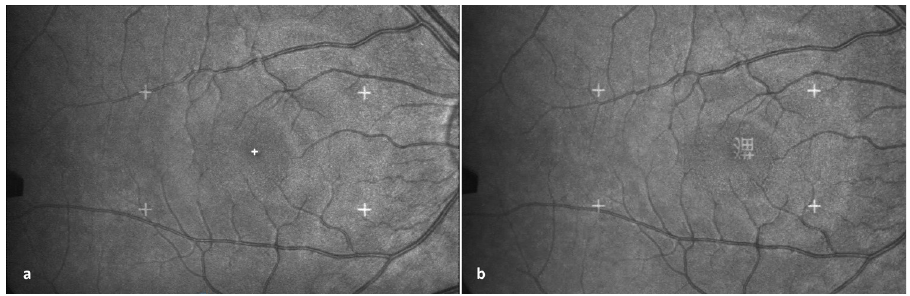
Fig 2. Analysis of the SLO data. The retina and the stimulus (here the character cat 猫 ) are seen upside down only by the examiner. The stimulus is seen upright by the child. The Chinese character is fixated with the fovea.